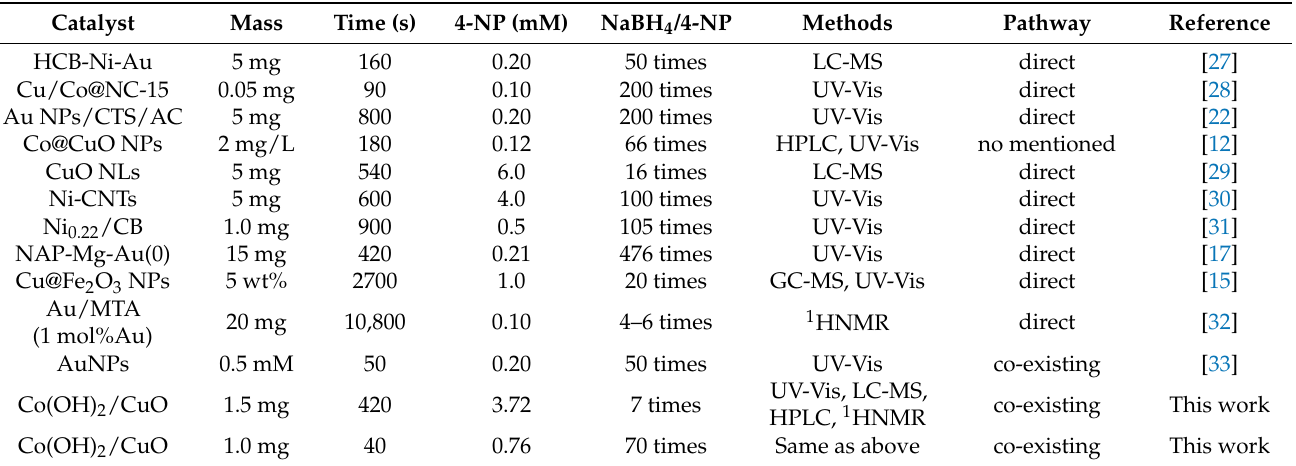
Table 2. Different analytical methods used in the reduction of 4-nitrophenol and the proposed reaction